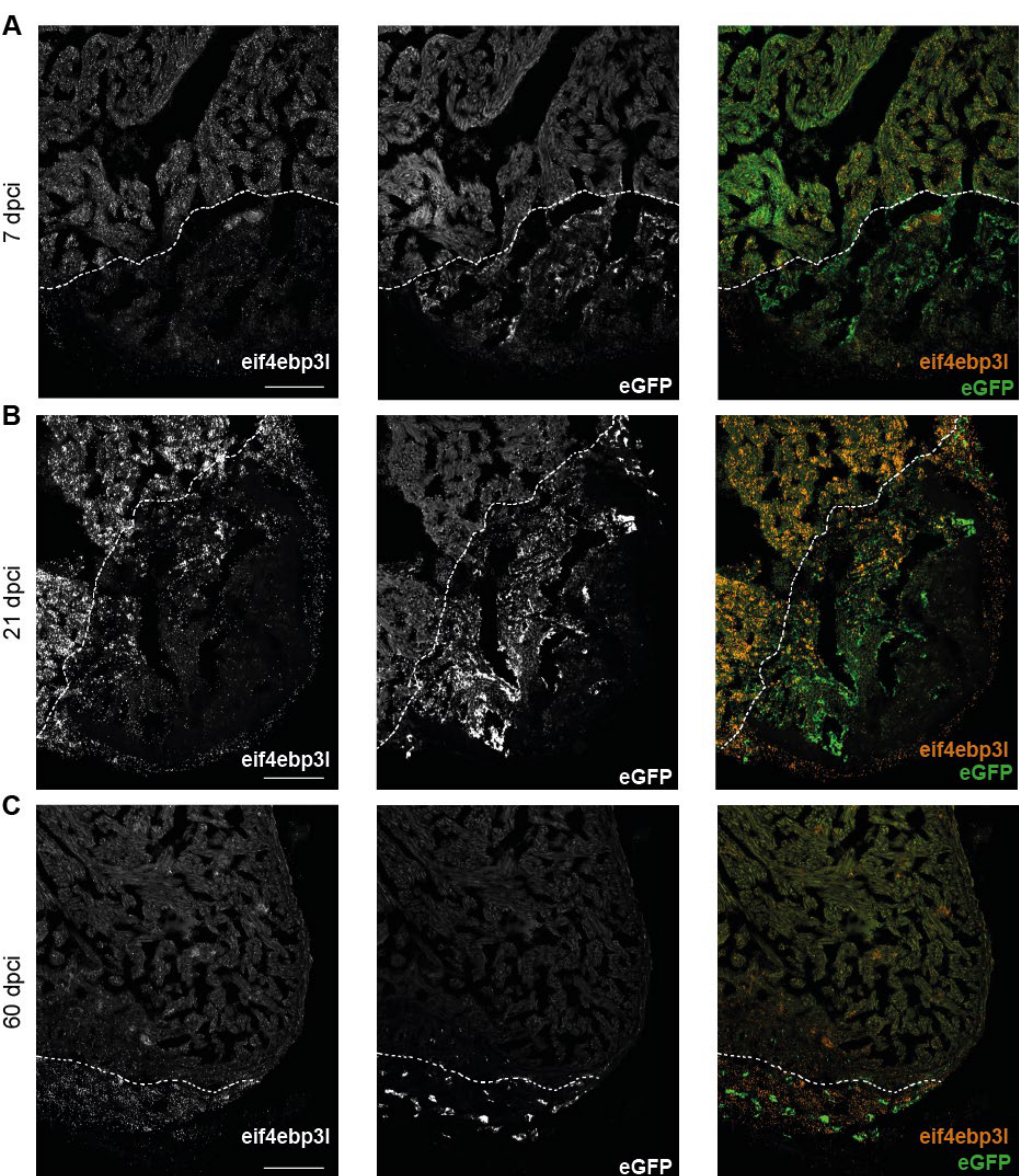
Figure 3. In the injured area the mRNA expression of eif4ebp3l decreased in the early phase of zebrafish heart regeneration. ( A – C ) RNAscope of the apex of Tg(fli1:eGFP ) zebrafish heart at 7 dpci, 21 dpci and 60 dpci. In the merged image mRNA expression of eGFP is visualized in green and eif4ebp3l in orange. Dashed lines highlight the approximate border to the IA. ( A ) Eif4ebp3l was highly expressed in the healthy myocardium and downregulated in IA. ( B , C ) With progressive regeneration of the zebrafish heart, the expression of eif4ebp3l recovered in the IA and reached the mRNA expression level of the healthy myocardium at 60 dpci. Scale bar = 100 µm.